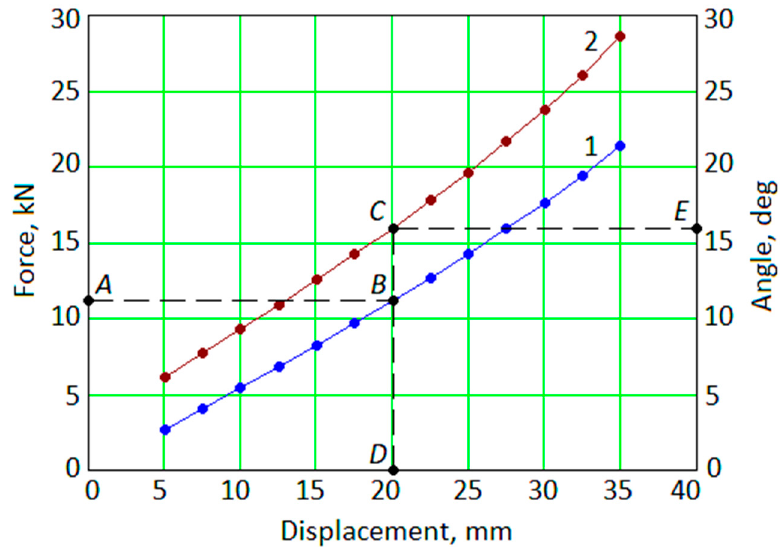
Figure 11. Dependencies of Q ( ∆ K ) [kN] (1) and α c ( ∆ K ) [deg] (2) on the displacement ∆ [mm].